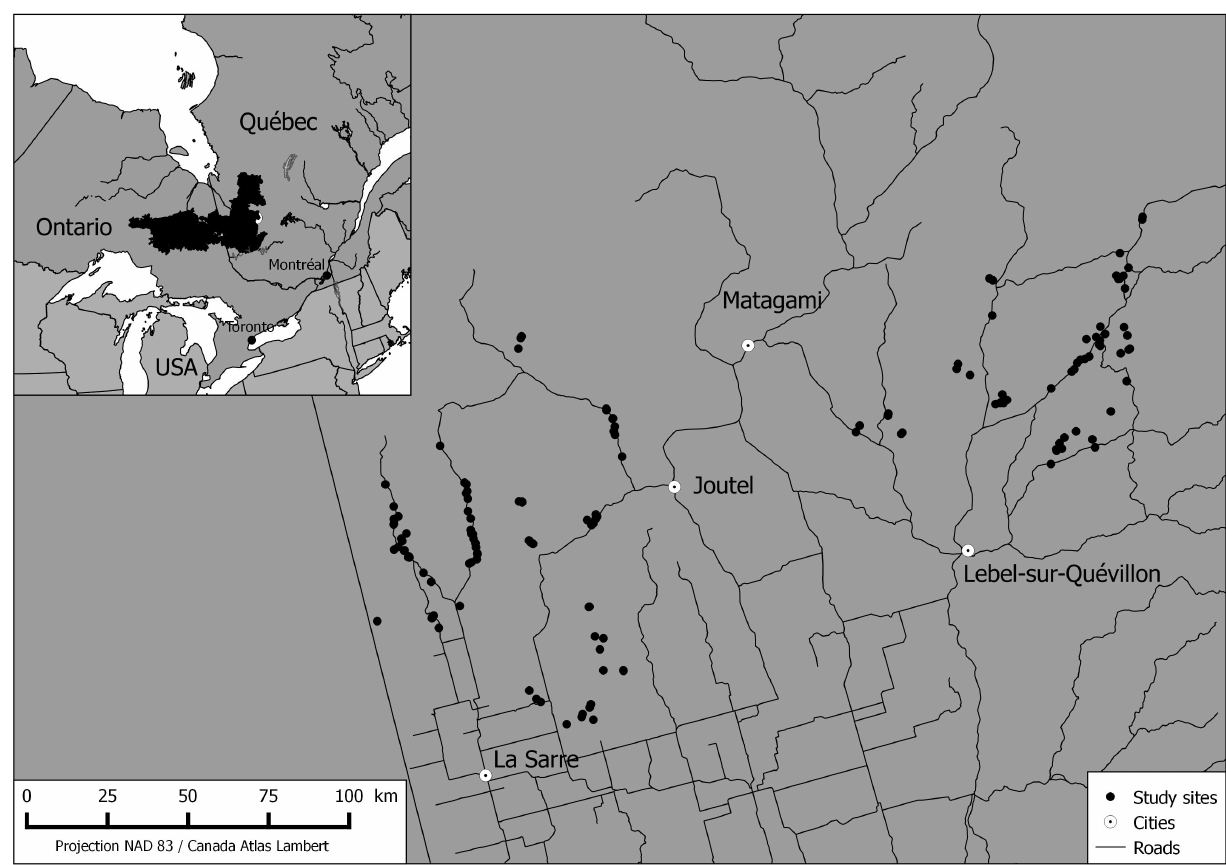
Figure 1. Location of the study area within the province of Quebec. Left panel: the clay belt of Quebec and Ontario. Right panel: selected study sites.